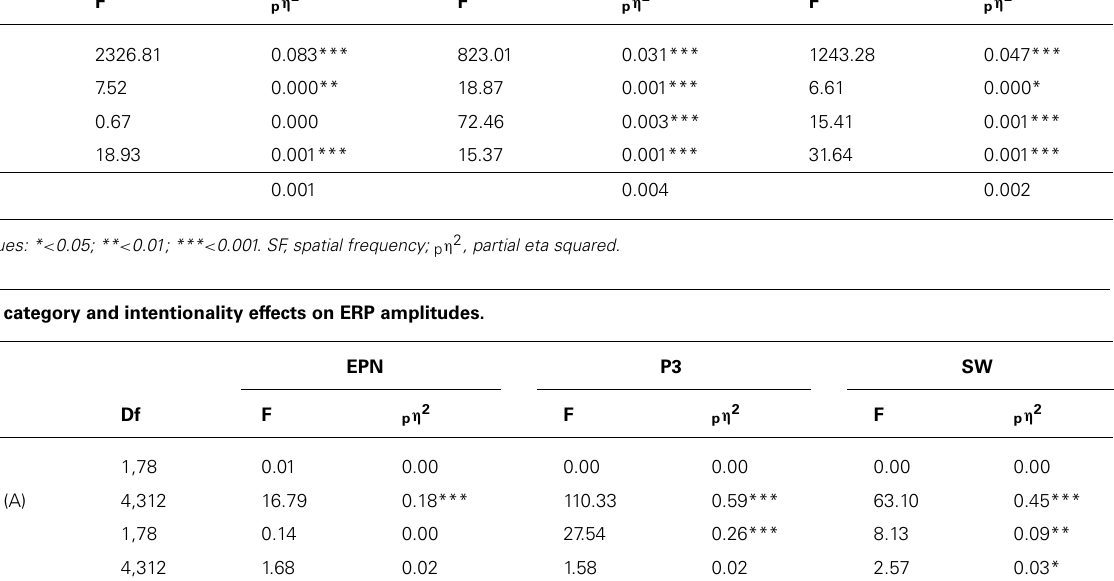
Table 1 | Contributions of physical stimulus features to single-trial ERP variability. EPN